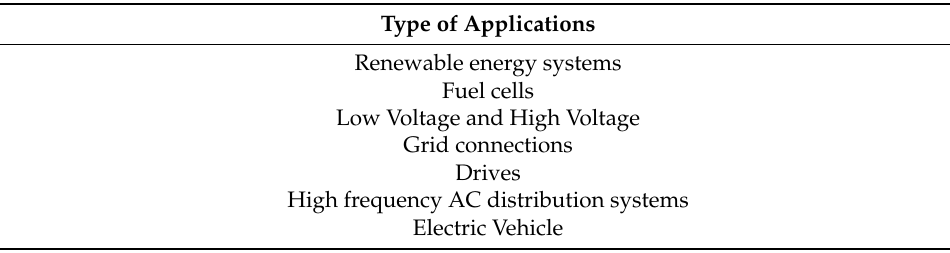
Table 1. Applications of MLI with reduced